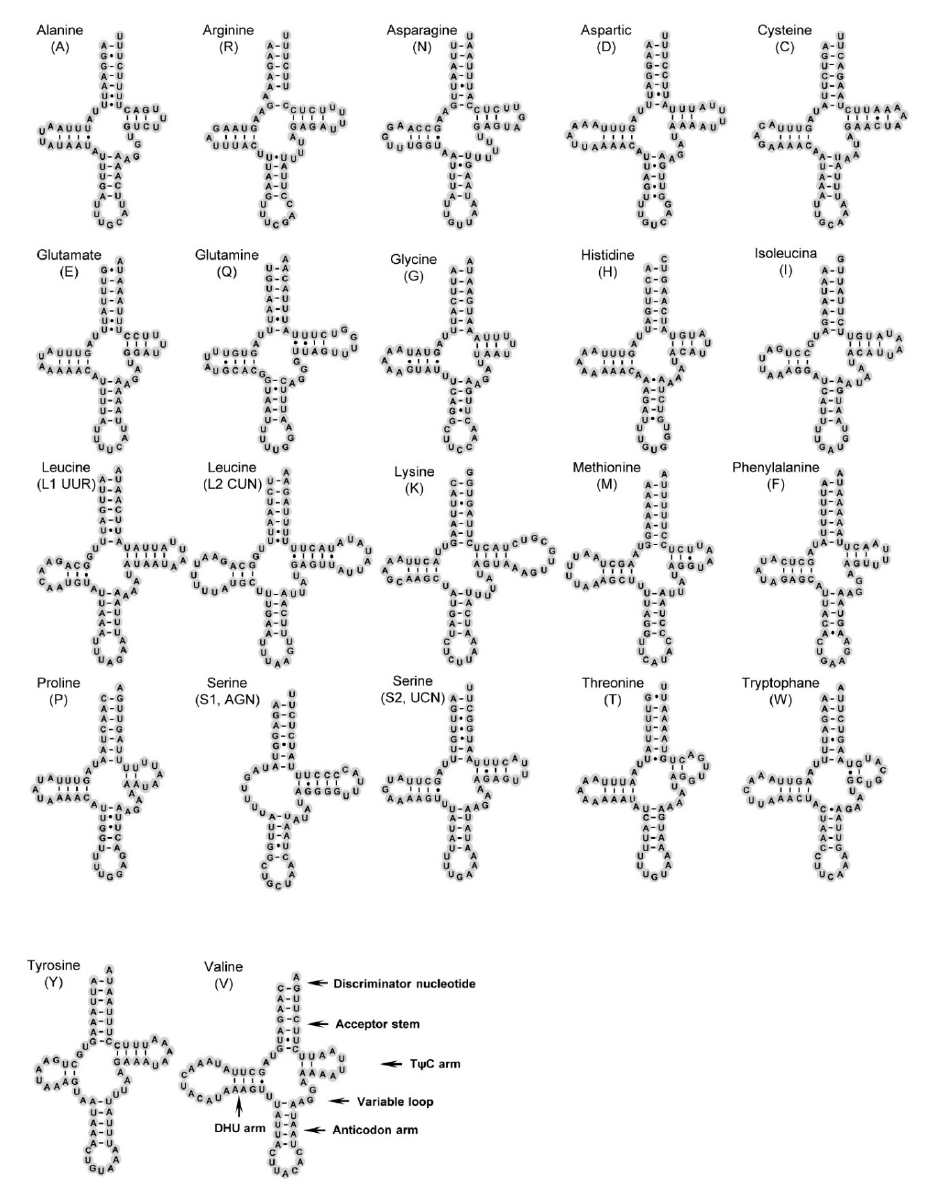
Figure 3. Predicted secondary cloverleaf structure for the tRNAs of P. chlorophana .